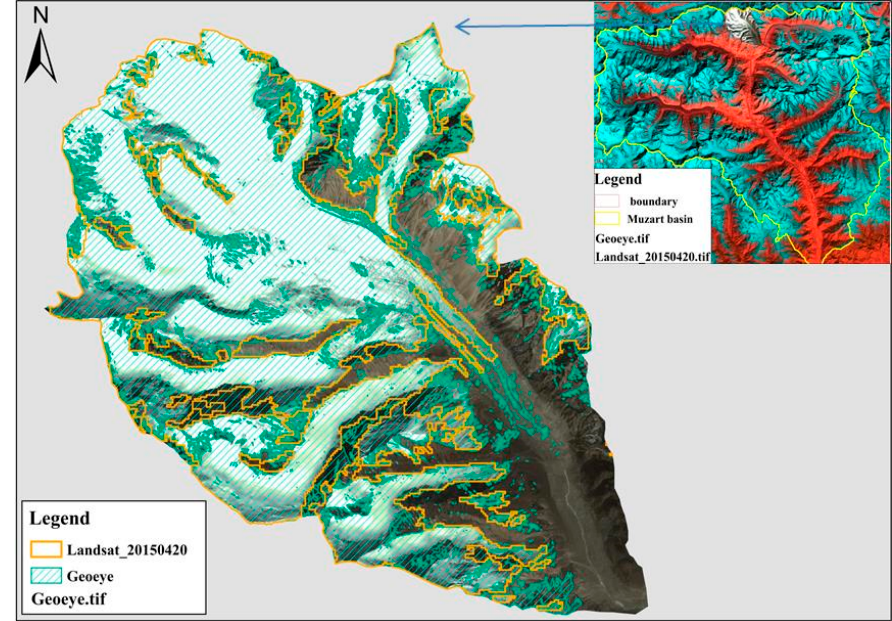
Figure 4. Glacier outlines derived from Landsat images (yellow polygons) and GeoEye images (blue polygon and background images) using object-based classification in the upper sub-catchment of the Muzart Glacier catchment on 20 April 2015. Table 1. Error matrix of glacier mapping between Landsat and GeoEye01 images in the upper sub-catchment of the Muzart Glacier catchment on 20 April